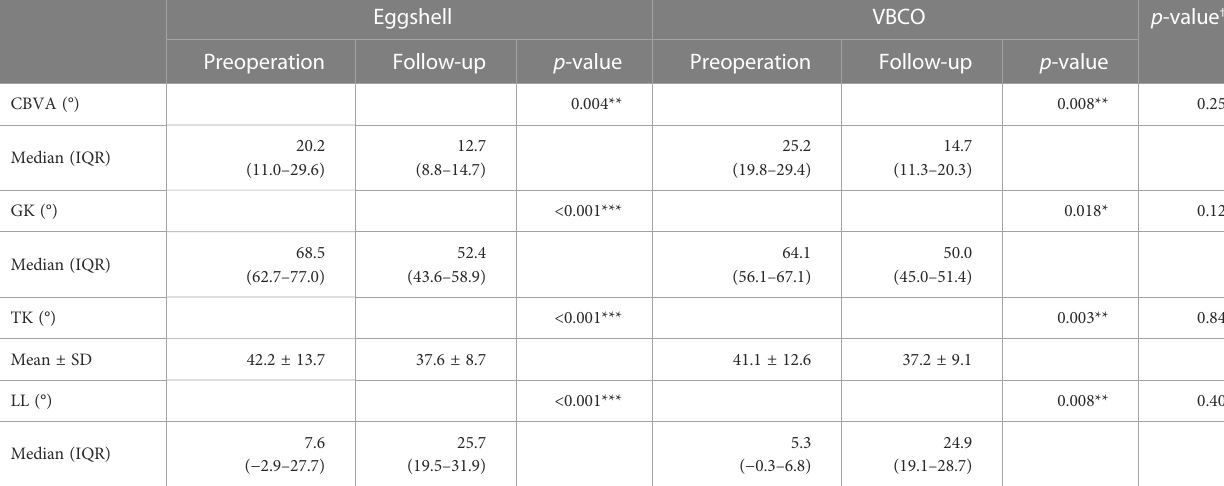
TABLE 5 Preoperative and follow-up radiographic